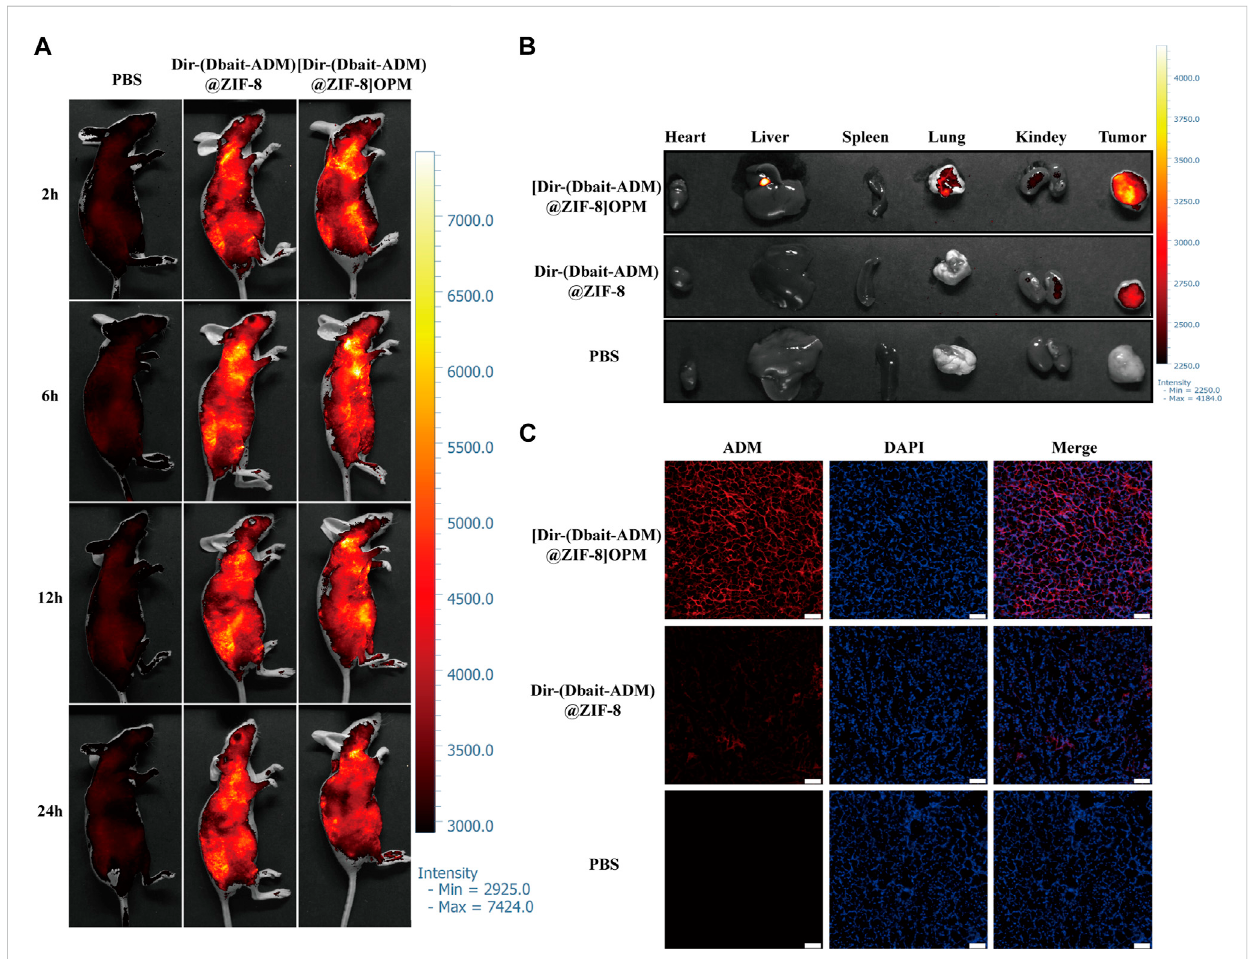
FIGURE 6 In vivo tissue distribution of [Dbait-ADM@ZIF-8]OPM. SaOS-2 tumor-bearing Balb/c nude mice were injected with PBS, Dir-(Dbait-ADM)@ZIF-8, and[Dir-(Dbait-ADM)@ZIF-8]OPM,respectively,inthetailvein. (A) Invivo imagesofmiceat2,6,12,and24 haftertreatmentineachoftheabovegroups. (B) Invitro imagesoftumorsandotherorgansat24 haftertreatment. (C) Invivo uptakestudies.FrozensectionsofexcisedtumorswerestainedwithDAPI and observed via fl uorescence microscopy. Scale bar, 50 μ